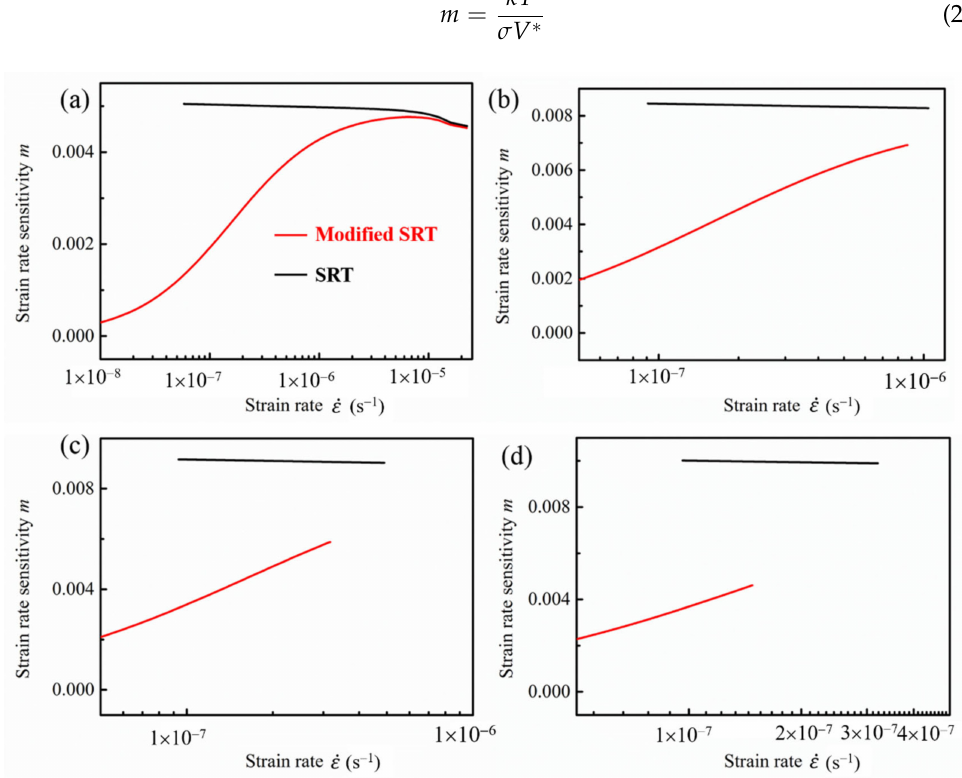
Figure 10. Comparison of the SRS obtained by conventional stress relaxation theory which does not take the grain boundary sliding into consideration and the SRS obtained by modified stress relaxation test taking the grain boundary sliding into consideration: ( a ) the first cycle; ( b ) the second cycle; ( c ) the third cycle; ( d ) the fourth